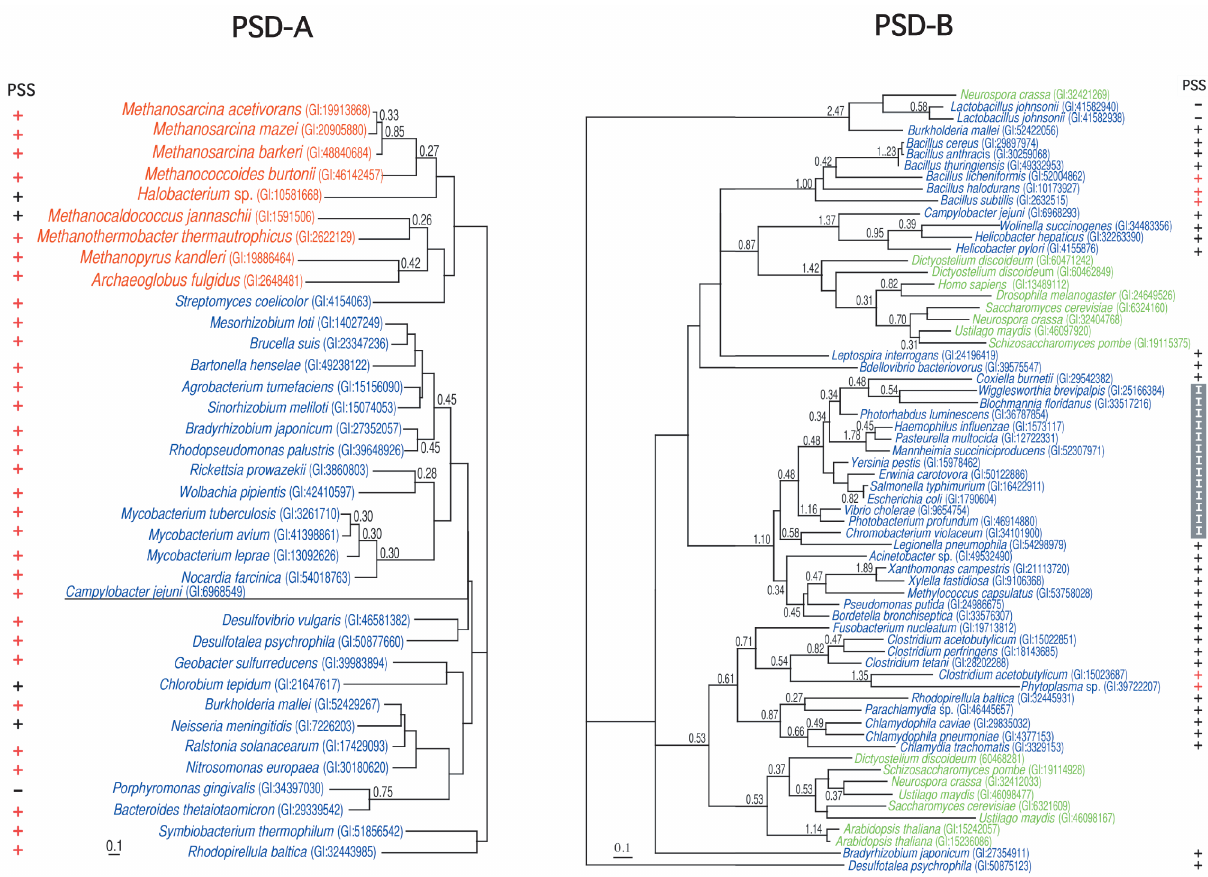
Figure 4. Two unrooted maximum likelihood trees of phosphatidylserine synthase/archaetidylserine synthase (PSS/ASS). Each sequence is indi- cated by the source name and the GI number from the National Center for Biotechnology Information. The colors for each species are the same as in Figure 3. The reliability index of a cluster is only shown when the value is equal to or greater than 0.25. The log likelihoods were –7157.86 and –18485.60 for phosphatidylserine decarboxylase-A and -B (PSD-A or PSD-B), respectively. The optimal shape parameter alpha was 0.85 (145 sites) for PSD-A and 1.13 (197 sites) for PSD-B. The presence or absence of ASS or PSS-II in each species is indicated by a symbol, ‘+’or ‘–’, near the source name. The symbol, ‘+’, colored red, shows that the genes or open reading frames for PSS/ASS and PSD/ASD are tandemly en- coded. When the species uses PSS-I instead of PSS-II, the symbol ‘+’is replaced with